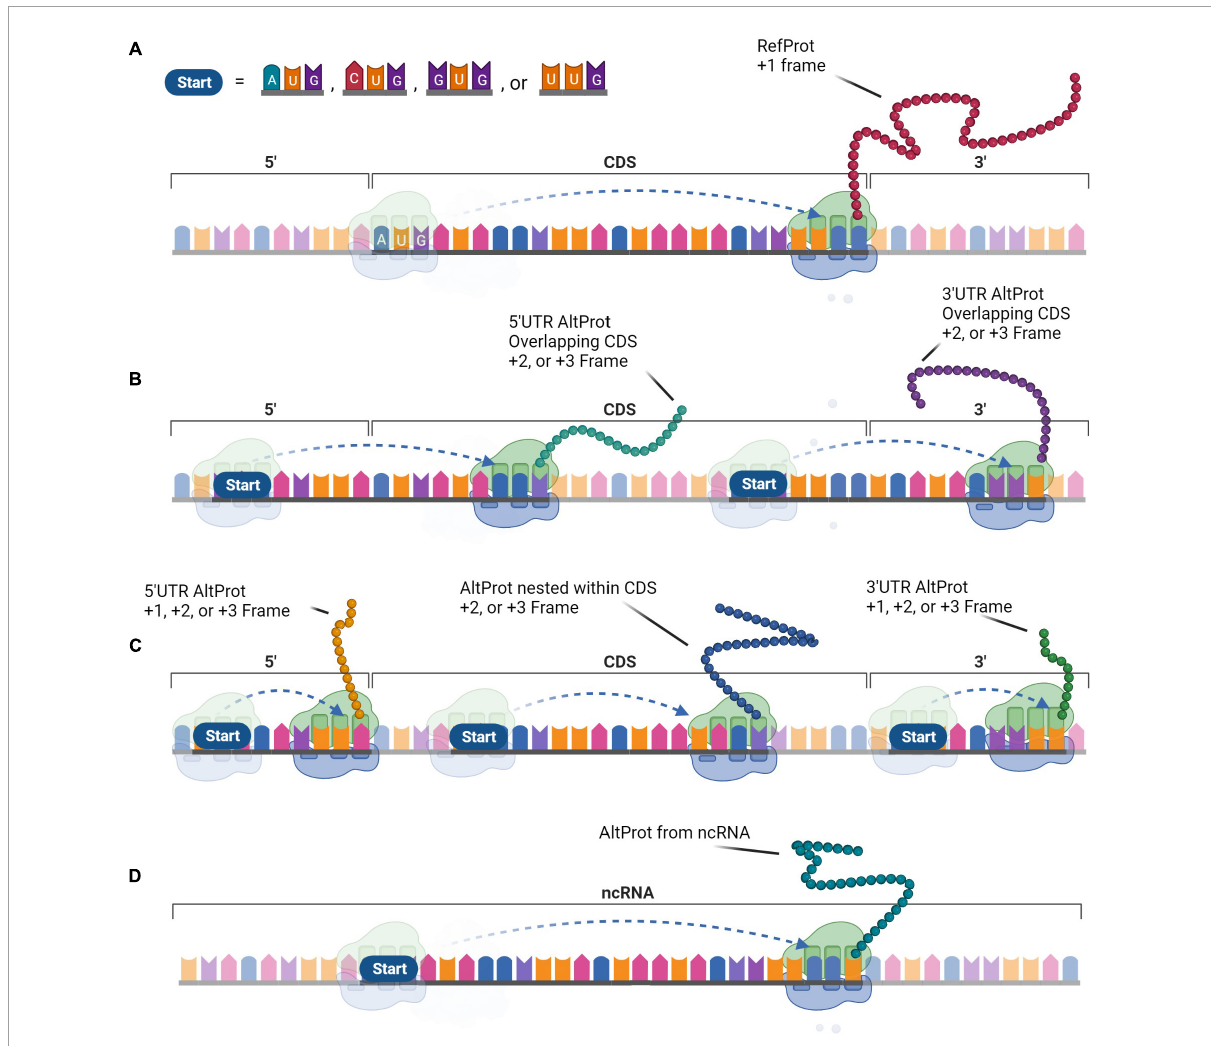
FIGURE2 The generation of protein diversity at the translational level. In contrast to the monocistronic transcript paradigm, protein diversity arises from the multi-coding properties of messenger RNA (mRNA) that expand the functional proteome. (A) The Reference protein (RefProt) is translated from the coding sequence (CDS) that is initiated by an AUG codon and is enclosed by the 3 (cid:48) - and 5 (cid:48) -UTR. Alternative proteins (AltProts) are translated from unannotated open reading frame (ORFs) that can initiate at AUG, CUG, GUG, or UUG codons. (B) These ORFs can overlap the CDS which will generate distinct protein sequences when the ORFs are out-of-frame. (C) In addition, translation from ORFs located within the 3 (cid:48) - or 5 (cid:48) -UTR, or from an out-of-frame ORF nested within the CDS will generate distinct protein sequences. (D) Finally, AltProts can be translated from transcripts that were previously considered non-coding. This perception can significantly expand protein diversity within